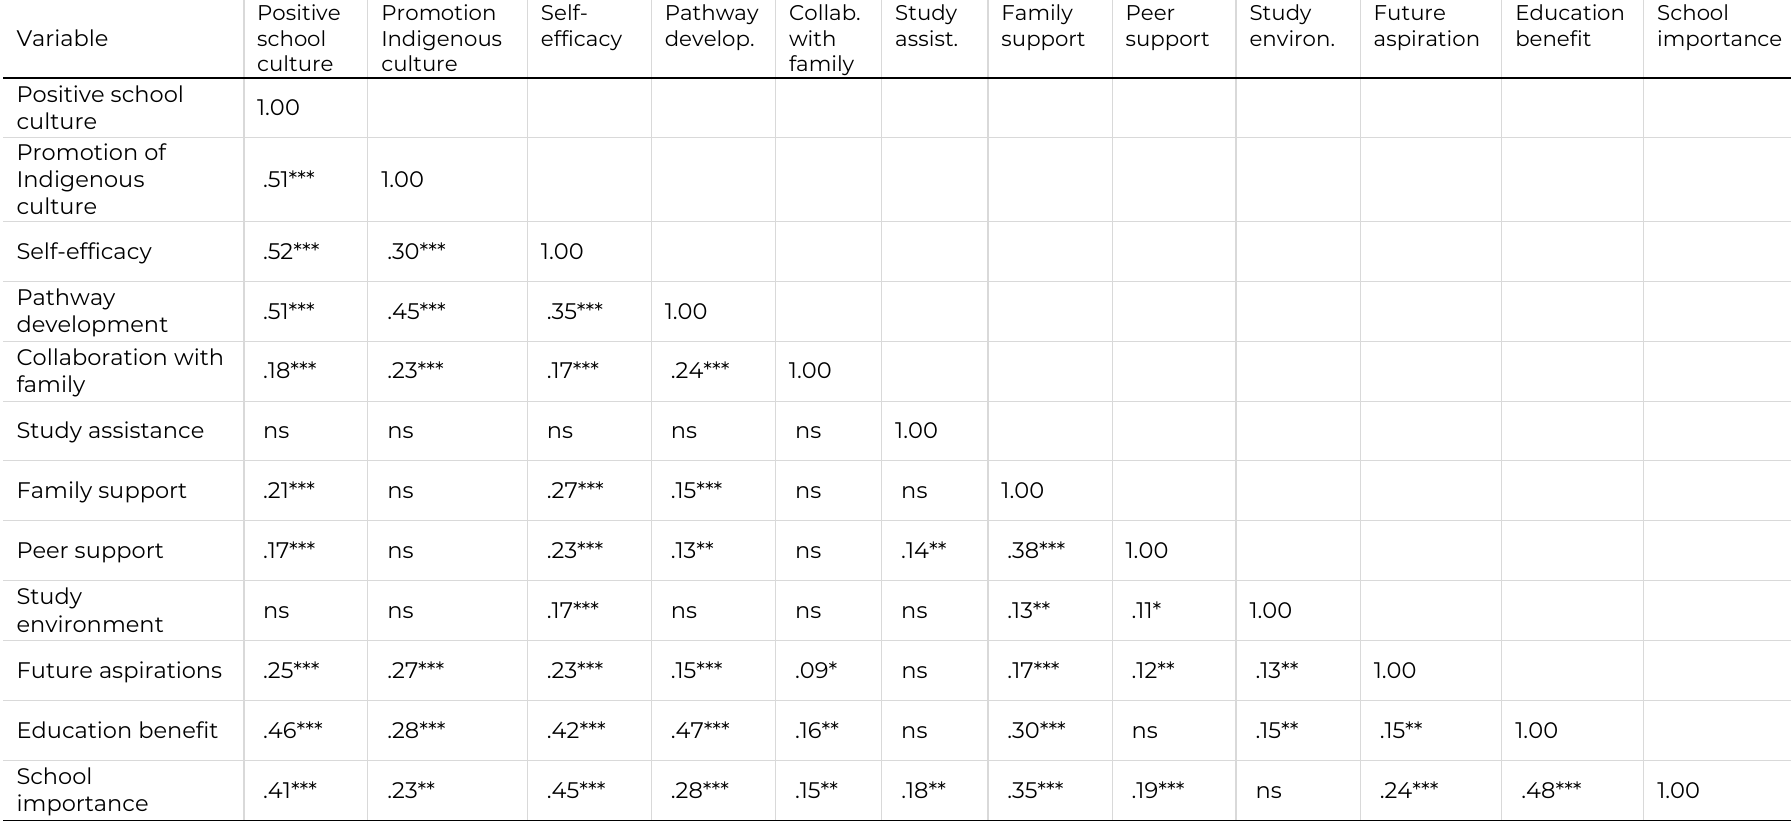
Table 3. Bivariate correlations between factors Variable develop.